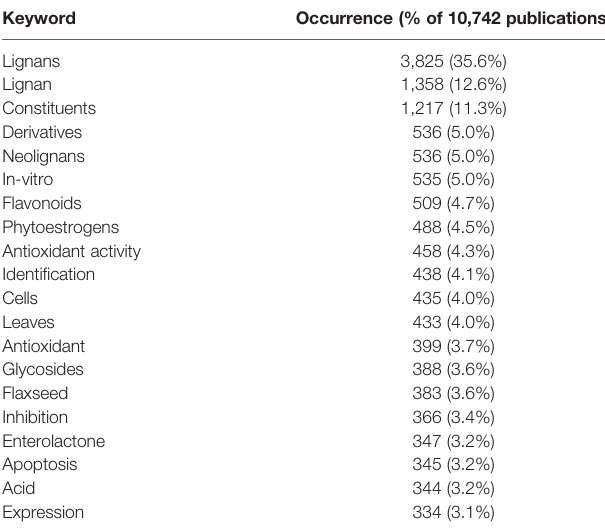
TABLE 4 | The top 20 recurring keywords.